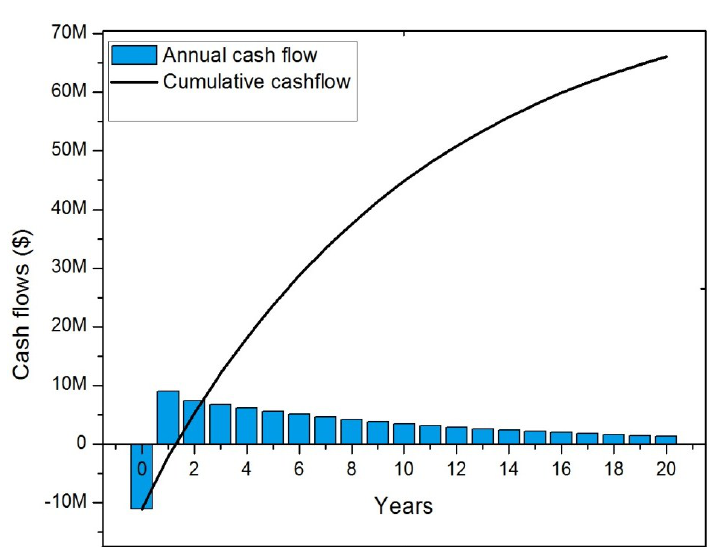
Figure 19. Cash flows of tri-generation